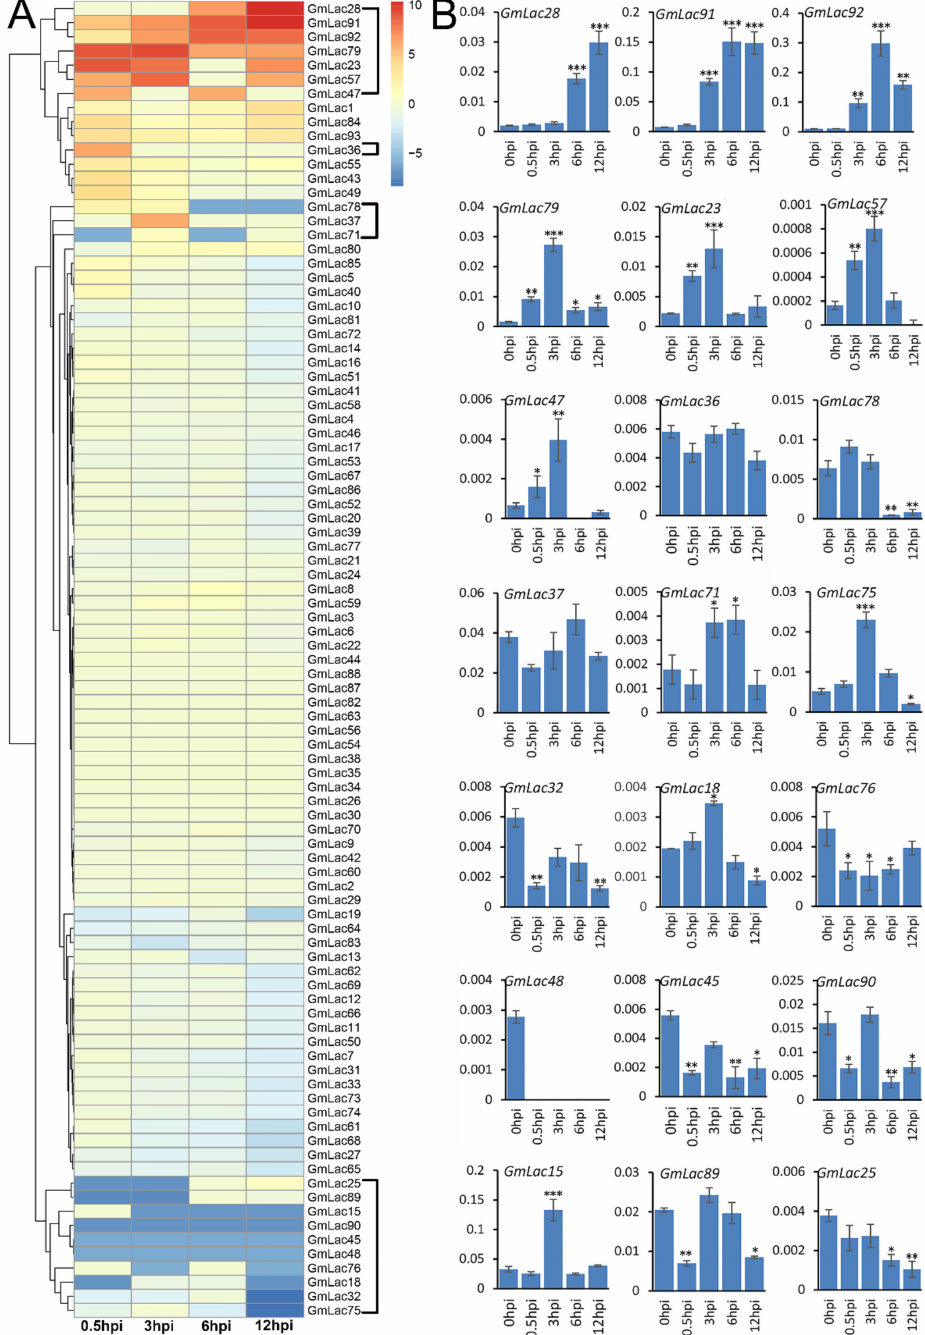
Figure 5. Expression profiles of the 93 soybean laccase genes following Phytophthora sojae infection. ( A ) Transcriptome heatmap. The hierarchical cluster color code: the highest induction values vs. controls are displayed in red (hot), while the values displayed in blue (cool) indicate the most reduced expression levels vs. controls; intermediate expression levels are represented by lighter intermediate colors. The color scale represents (cid:52) FPKM normalized to log2-transformed vales. The genes marked by the black brackets on the right in ( A ) are those obviously mis-regulated genes. ( B ) Expression levels of 21 GmLac s after P7076 infection. Bars represent average values of three replicates ± standard deviation (SD). All expression levels of the GmLac genes were normalized to the expression levels of GmPDF . ***, **, and * indicate significant di ff erences compared to the control (0 h) at p < 0.001, p < 0.01, and p < 0.05,